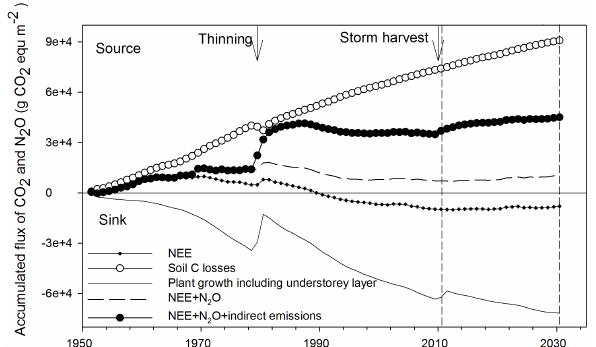
Figure 6. Simulated total GHG balance for the forest ecosystem from 1951 to 2011 and extended to 2031. The simulated results of 2011 to 2031 are obtained by running the “vegetation fitted model” with meteorological data from 1991 to 2011 extended to represent the climate of 2011 to 2031. It should be noted that the GHG bal- ance presented in this figure assumes no final